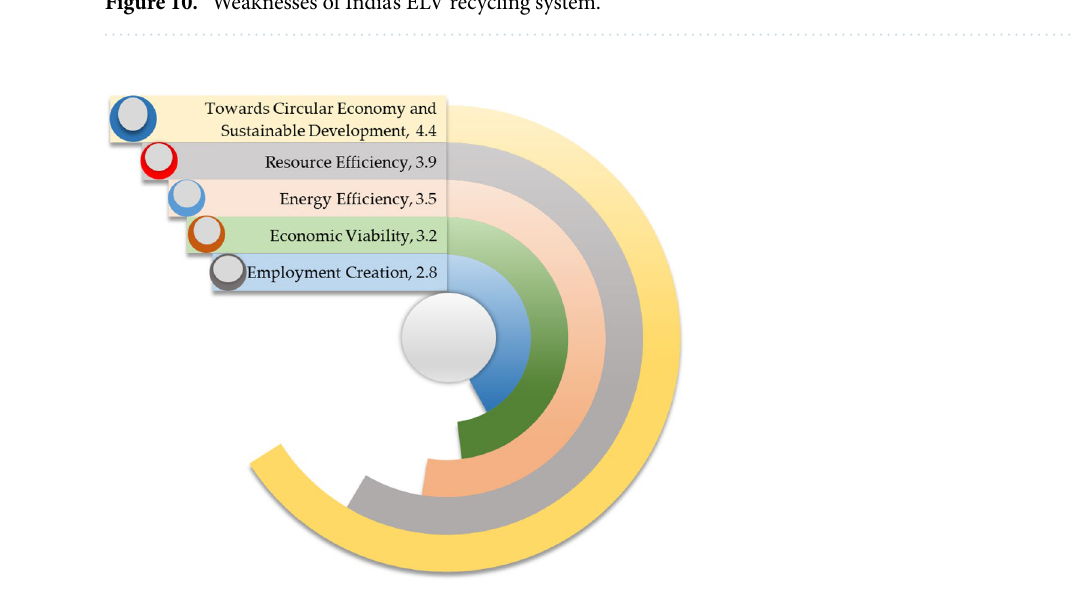
Figure 10. Weaknesses of India’s ELV recycling system.